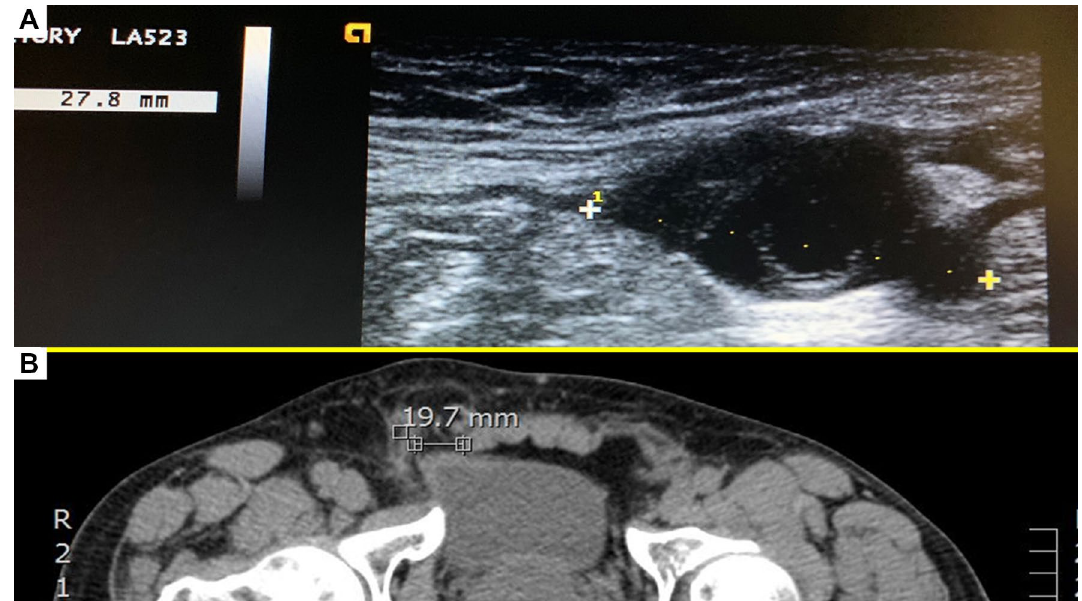
Figure 2. Preoperative hernia defect assessment. ( A ) Ultrasound image of midsized defect of the inguinal backwall. ( B ) CT scan showing small inguinal hernia defect in the right